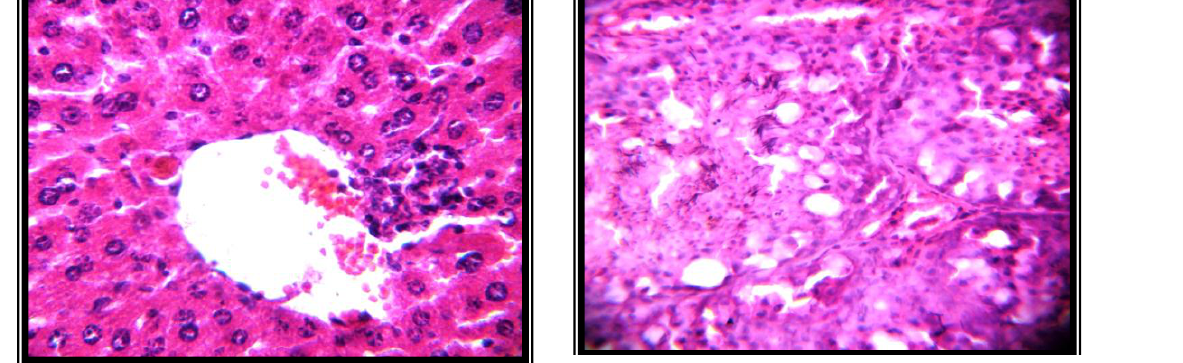
Fig. 5 (H&E 400 X): Histological sections of mouse liver treated orally with MSG at a dose of 3g per Kg of body weight showed large numbers of hepatocytes contain large nuclei with more nucleoli.